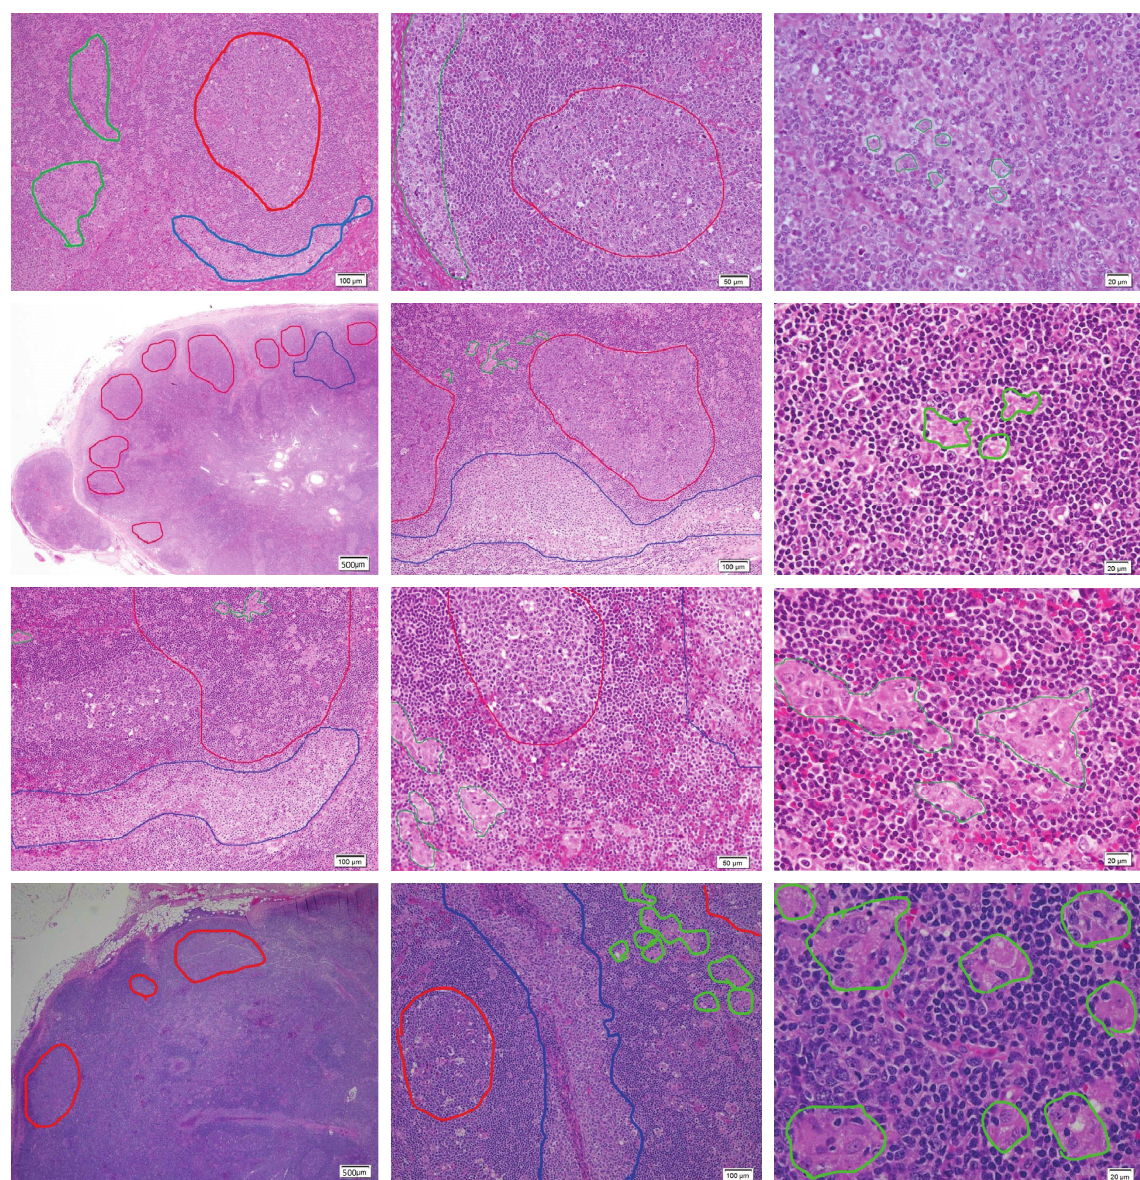
Figure 1: Microscopic findings of hematoxylin-eosin-stained lymph nodes in four cases of Toxoplasma infection (cases 2–5). Case 2: reactive follicles (red line circle), clusters of epithelioid cells (histiocytes, green line circle), and patches of monocytoid cells (monocyte-like cells, blue line circle); (hematoxylin-eosin stain) the first row, left: × 100 (microscope total magnification), mid: × 200, and right: × 400. Case 3: reactive follicles (red line circle), epithelioid cell clusters (histiocytes, green line circle), and monocytoid cell patches (monocyte-like cells, blue line circle); (hematoxylin-eosin stain) the second row, left: × 20, mid: × 100, and right: × 400. Case 4: reactive follicles (red line circle), epithelioid cell clusters (histiocytes, green line circle), and monocytoid cell patches (monocyte-like cells, blue line circle); (hematoxylin-eosin stain) the third row, left: × 100, mid: × 200, and right: × 400. Case 5: reactive follicles (red line circle), epithelioid cell clusters (histiocytes, green line circle), and monocytoid cell patches (monocyte-like cells, blue line circle); (hematoxylin-eosin stain) the fourth row, left: × 20, mid: × 100, and right: ×